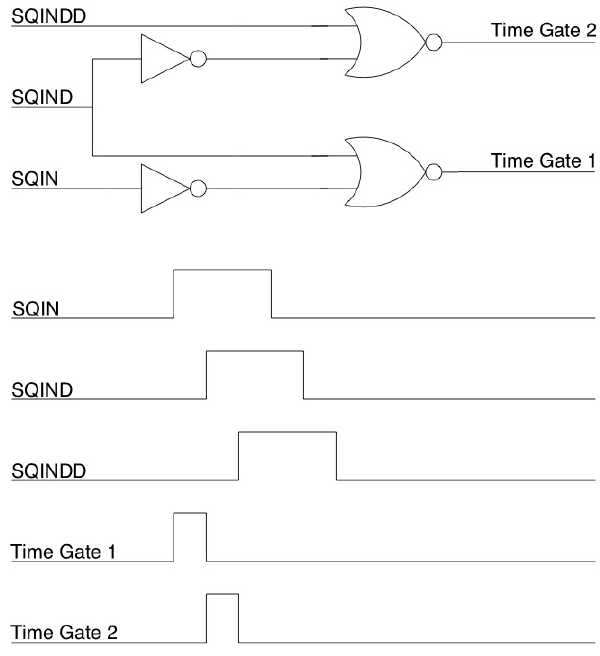
Figure 10. Circuit and timing diagram for in-pixel time-gate